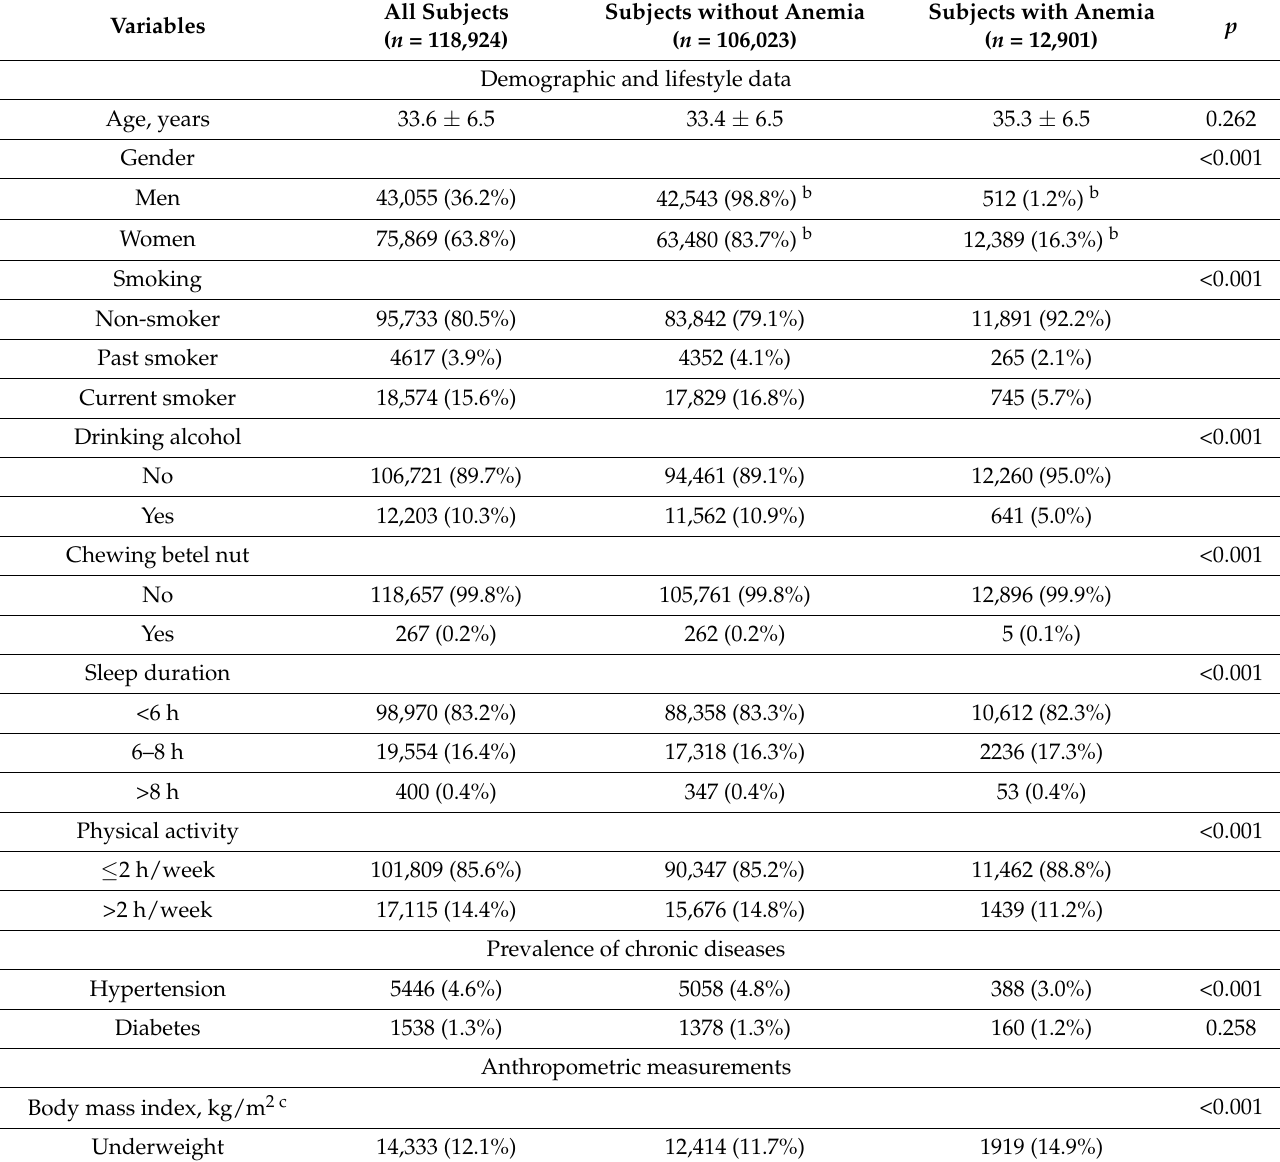
Table 1. Characteristics of study participants aged 20–45 years ( n = 118,924) a